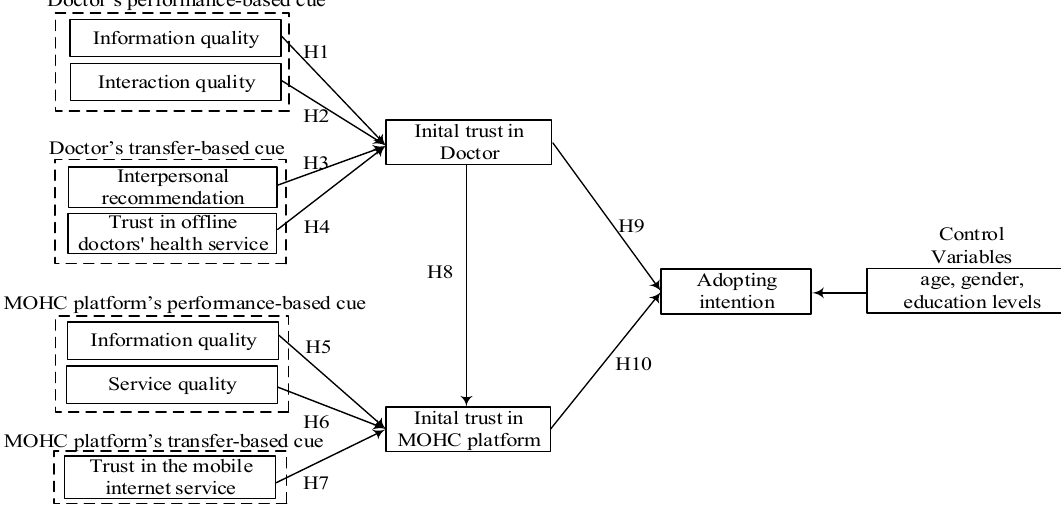
Figure 1. Conceptual model.